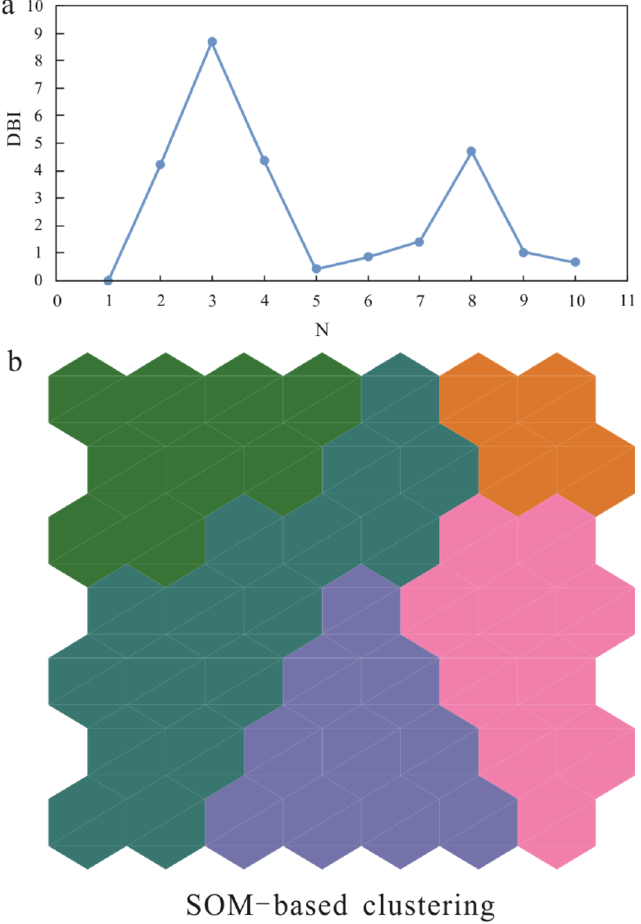
Figure 11. SOM-based cluster diagram (( a ). The value of the DBI ( b ). Different colors indicate dif- ferent clusters).